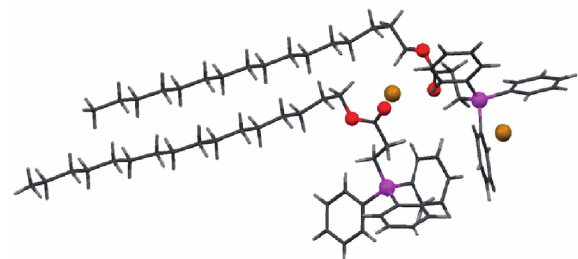
F 1: Molecular structure of the asymmetric unit of